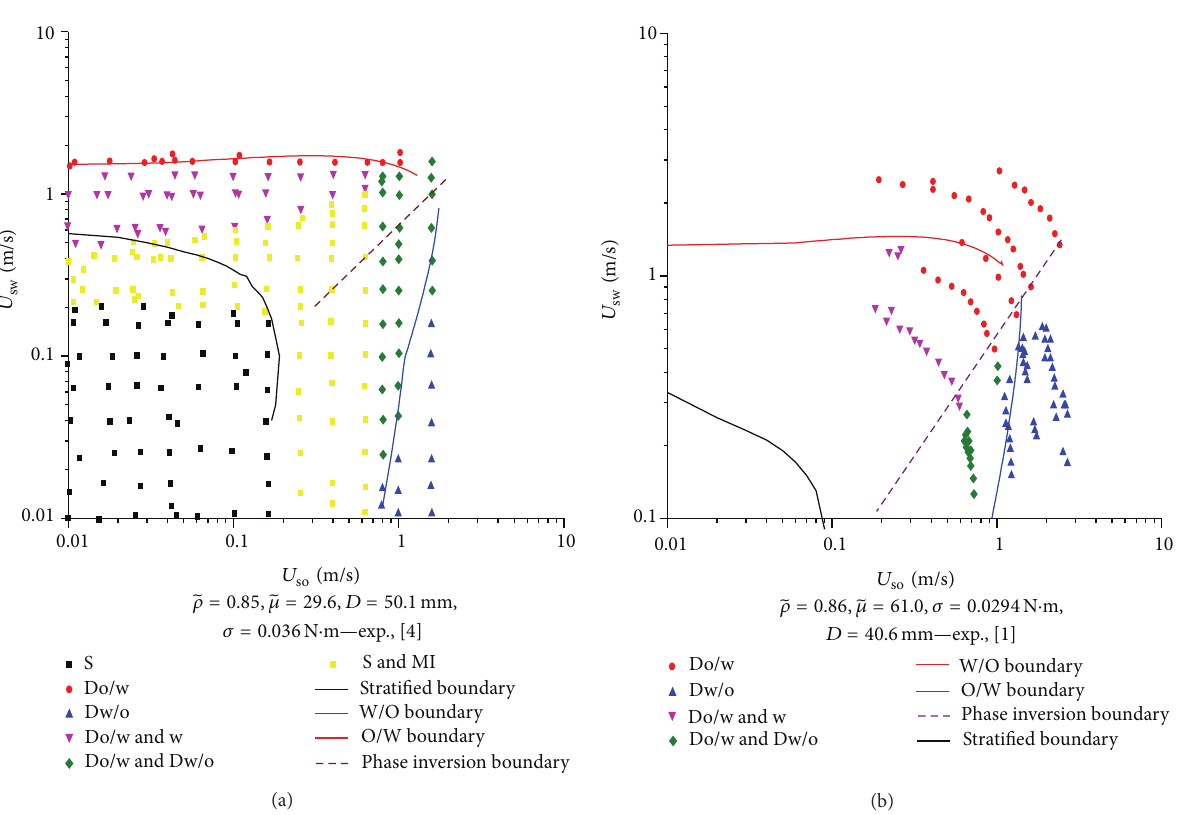
Figure 3: Comparison of experimental data (symbols) and prediction (lines) of oil-water two phase flow pattern